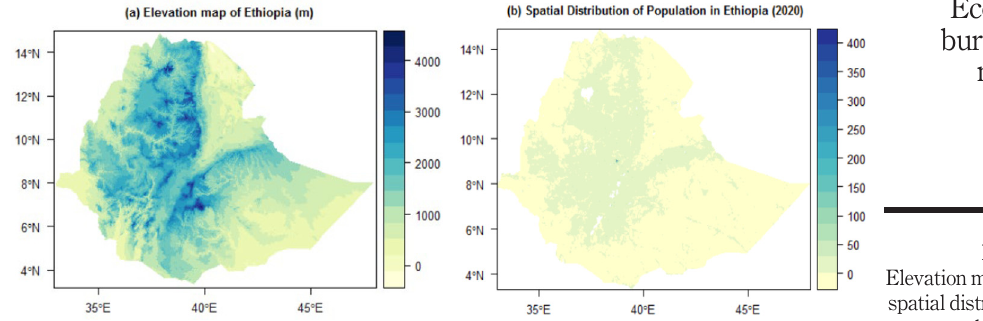
Figure 2. Elevation map (a) and spatial distribution of population (b) in